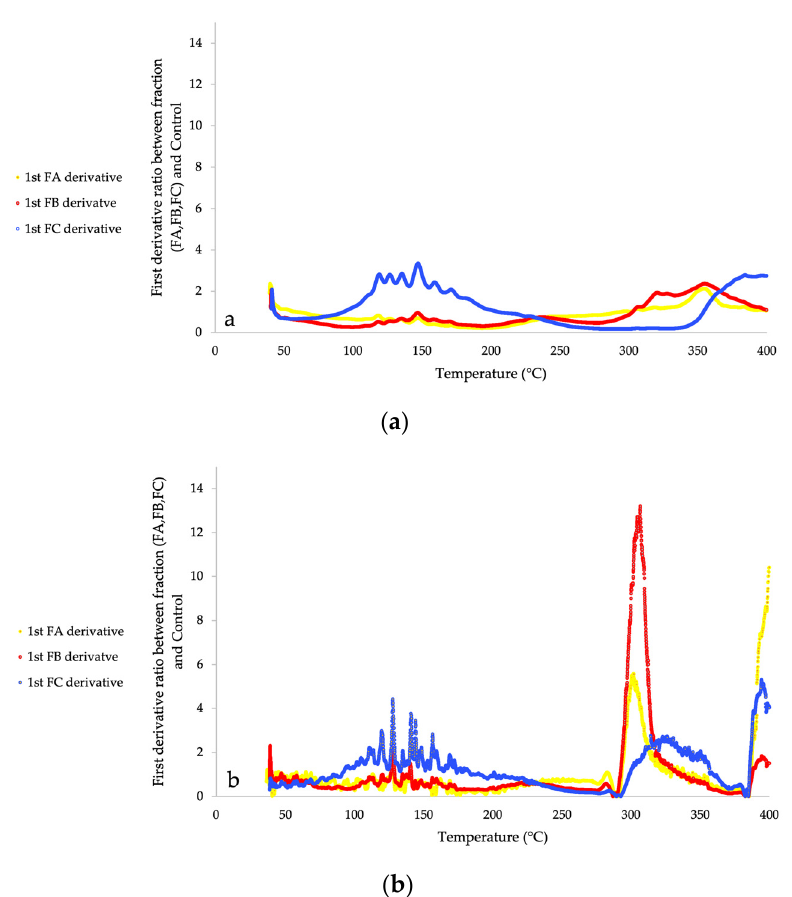
Figure 5. First derivatives ratio of Van Soest Fractions in compared to Control under argon ( a ) and oxygen ( b ).